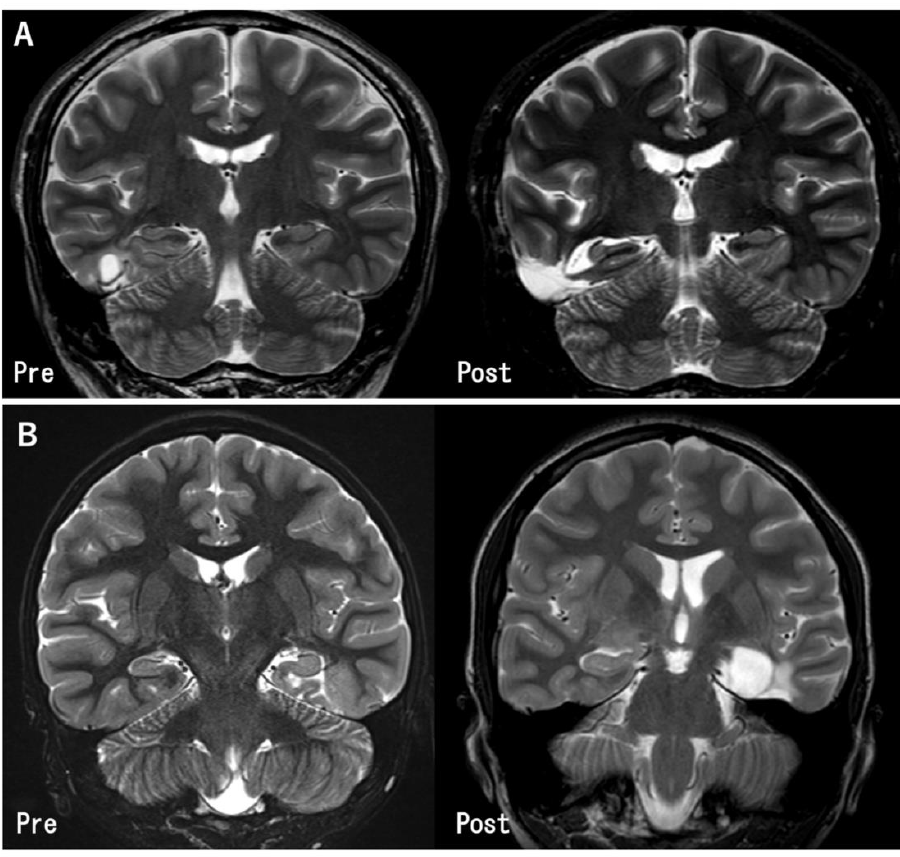
Figure 2. Pre- and post-operative MR images in the representative cases. ( A ) The tumor in the inferior temporal gyrus was totally removed. The hippocampus was preserved because it was located apart from the tumor (Case 11). ( B ) The tumor was located at the left parahippocampal gyrus. Gross total tumor removal and hippocampectomy was performed (Case 27).